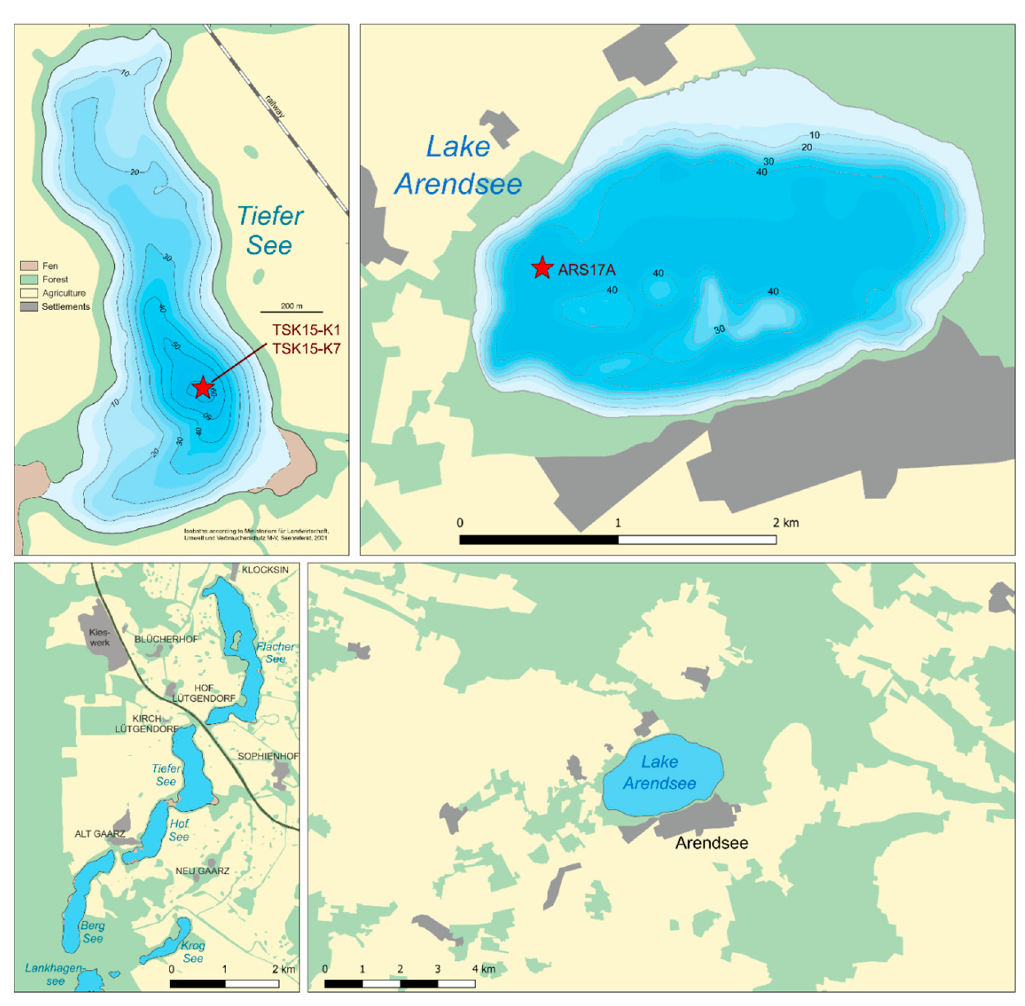
Figure 2. Detailed maps of Lake Tiefer See and Lake Arendsee.